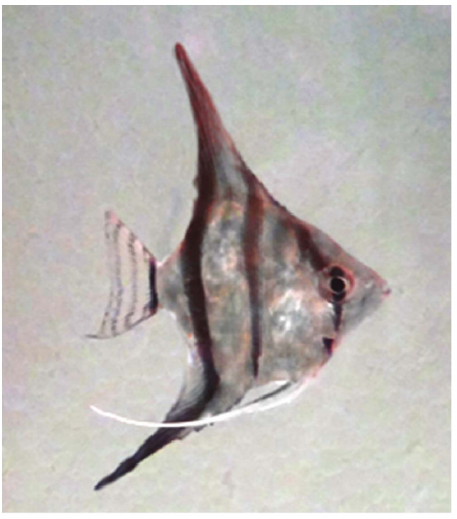
Figure 1. One of the experimental angelfish ( Pterophyllum scalare ).